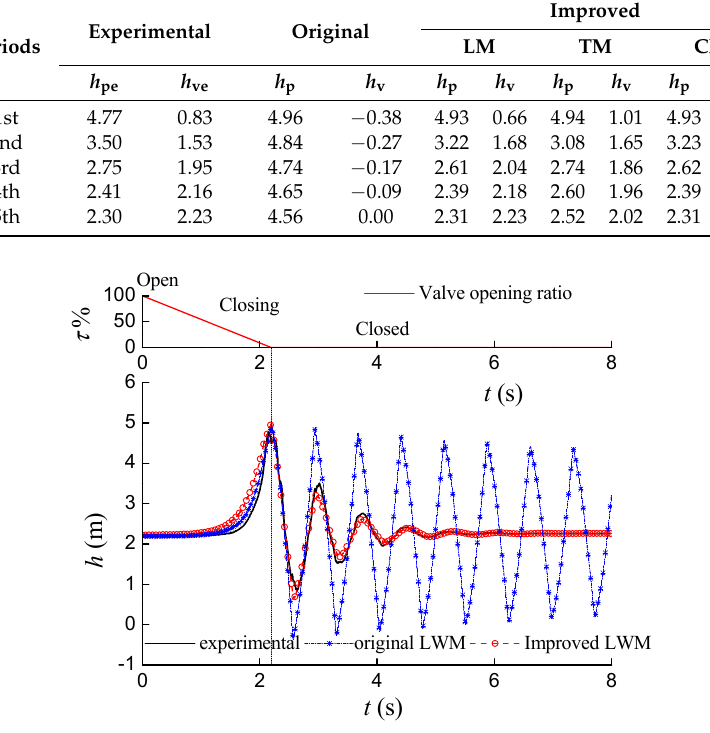
Figure 11. Simulation by improved two-phase model.